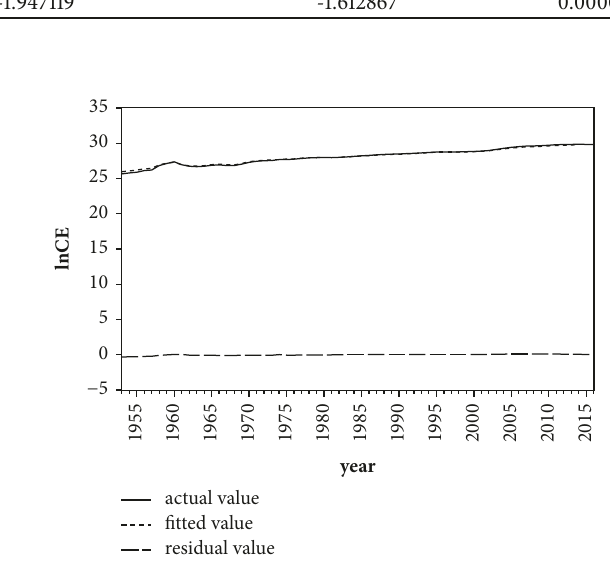
Figure 5: Fitting test of long-term equilibrium relationship